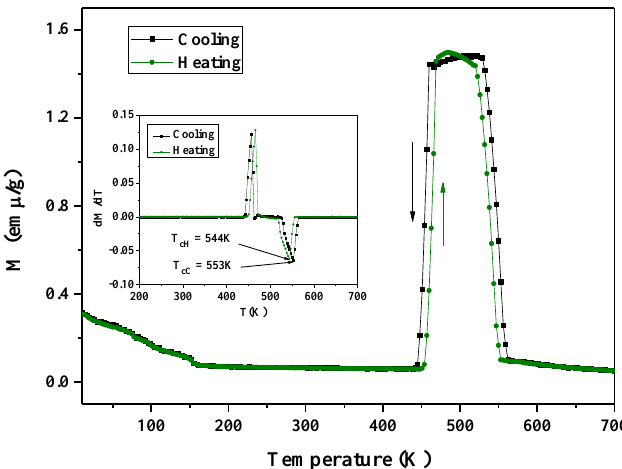
Figure 21. The ZFC and ZFH temperature dependence of the magnetization under static magnetic fields of 50 mT for the Co 1 − x Ni x In 2 (x = 0.540) compound.